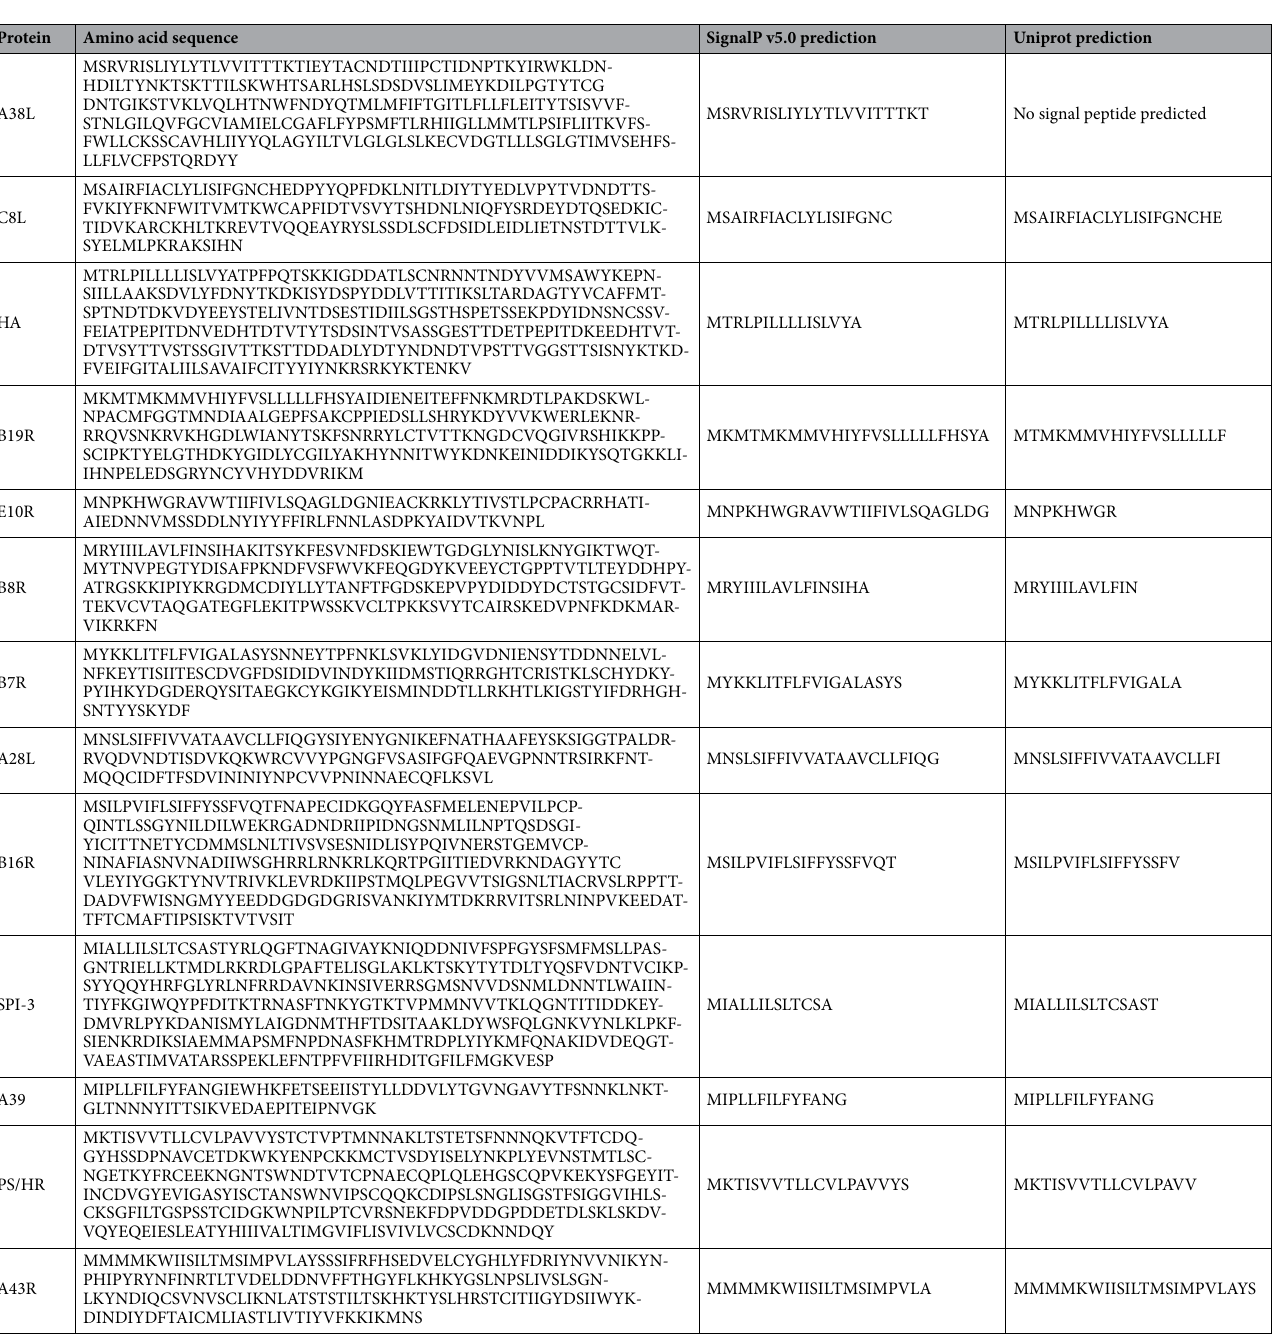
Table 3. Predicted proteins containing predicted signal peptides. For each predicted protein, the conventional signal peptide as stated by Uniprot is listed, as well as the signal peptide predicted by SignalP v5.0. A novel signal peptide was predicted by SignalP v5.0 for the protein